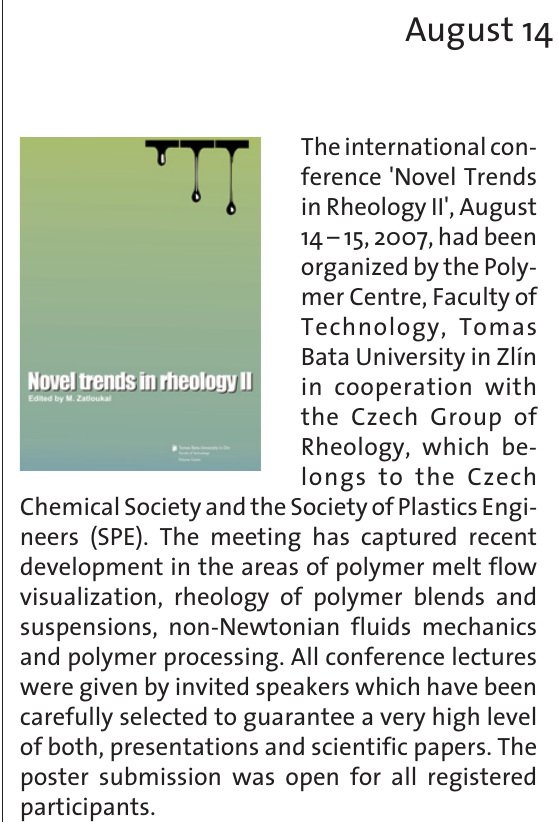
Figure 1 (left above): Lecturing room Figure 2 (right above): Discussion after the lectures Figure 3 (left below): Refreshment Figure 4 (right below): Exhibition